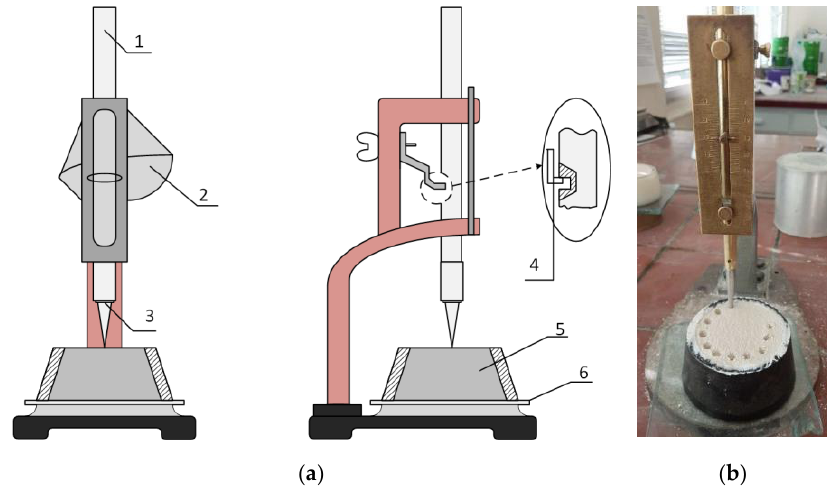
Figure 2. The Vicat apparatus used in the tests: ( a ) diagram and ( b ) photo: 1—guide, 2—release